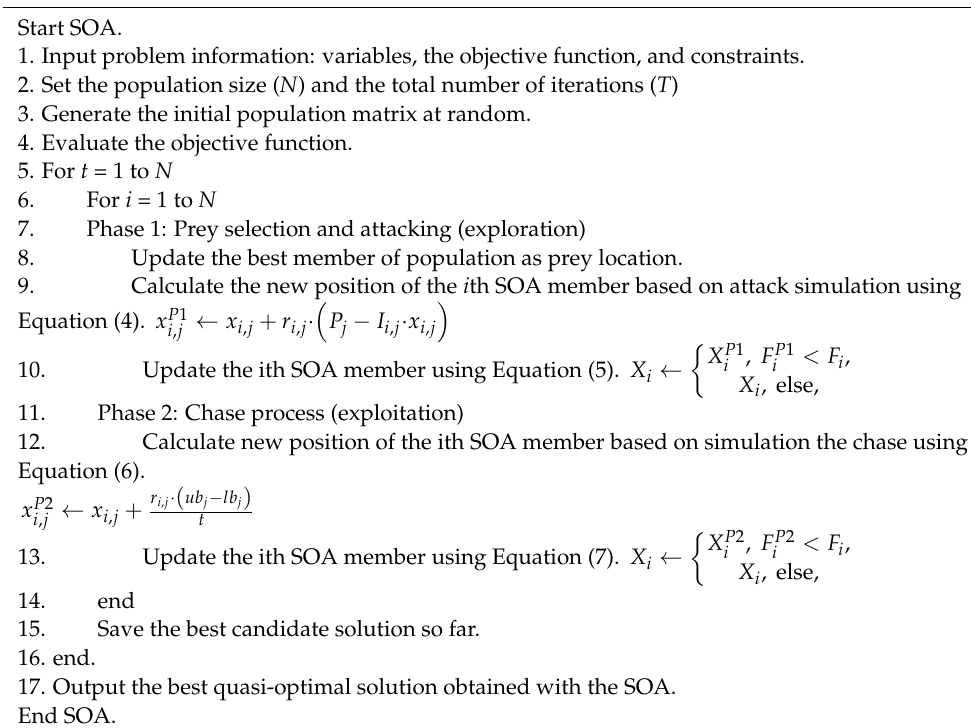
Algorithm 1 Pseudocode of the